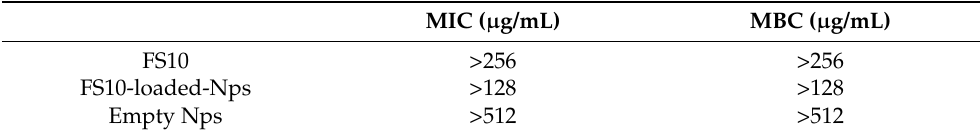
Table 3. The determination of the MIC and MBC of FS10, FS10-loaded-Nps, and empty Nps versus S. aureus ATCC 43300. The results represent the mean of two independent experiments performed in triplicate.